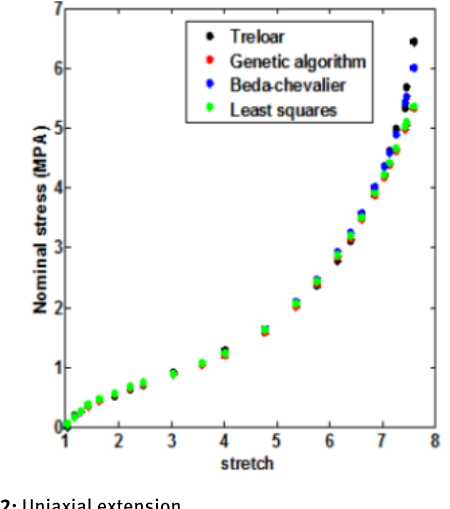
Figure 2: Uniaxial extension.